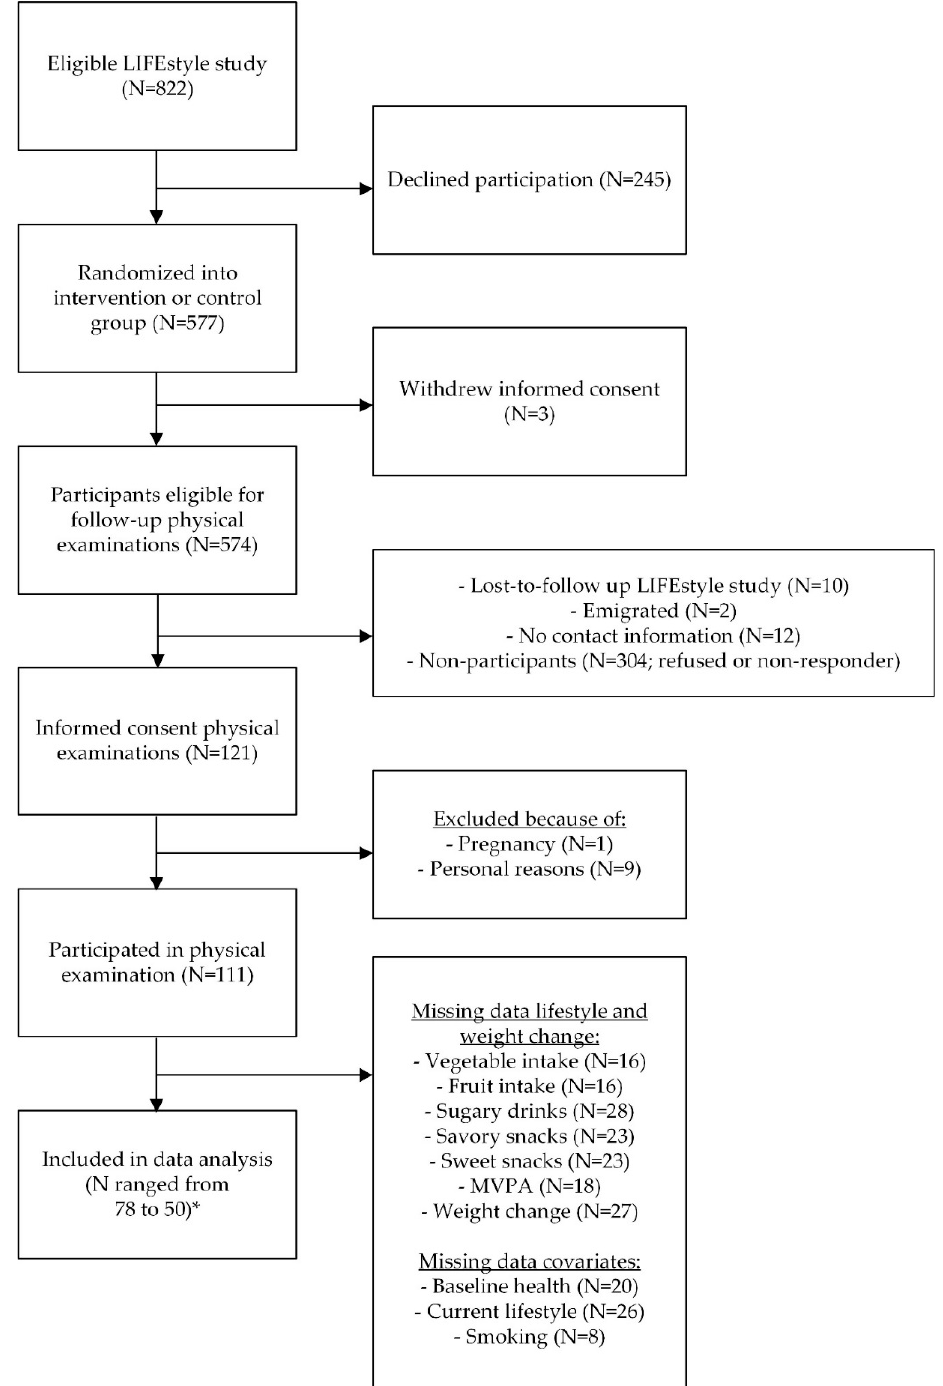
Figure 1. Flow-chart of the study participants. MVPA = Moderate to Vigorous Physical Activity * N depends on missing data in the combined models including independent variables and covariates.